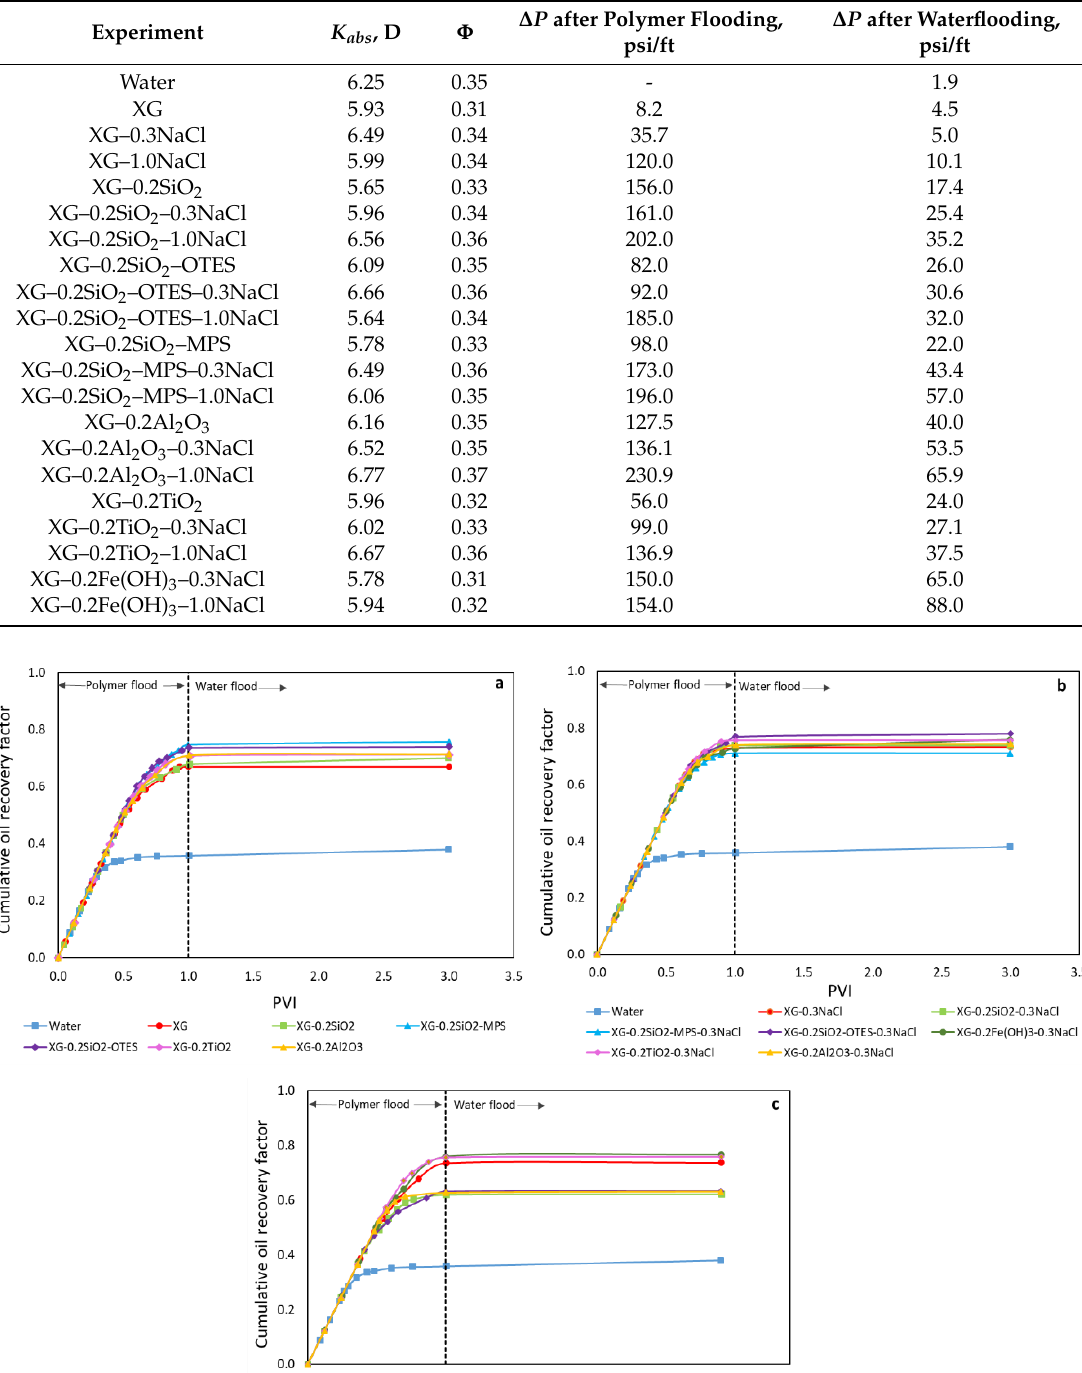
Table 3. Properties of the sand-pack and ∆ P after water and polymer flooding.